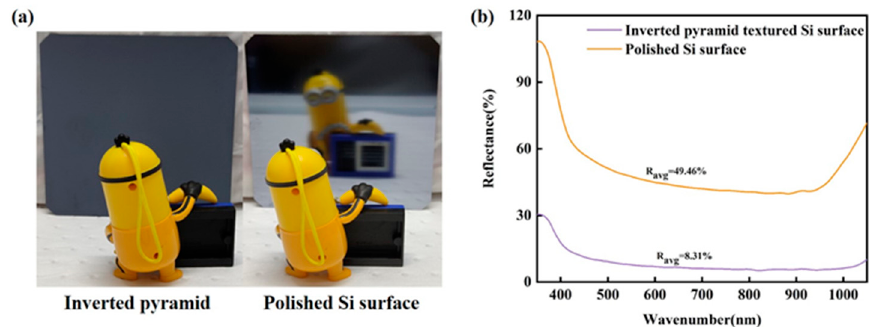
Figure 1. Photograph ( a ) and reflectance spectrum ( b ) of polished and etched samples in Ag@PVP–ACE.